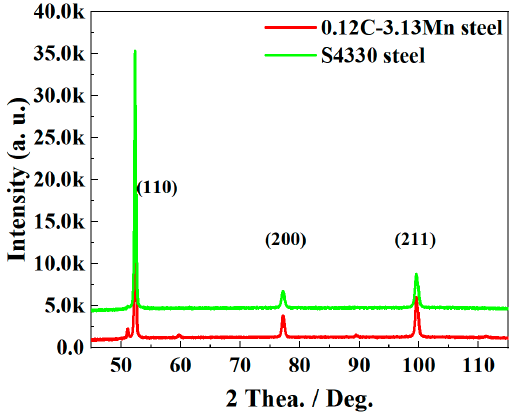
Figure 6. XRD profiles of 0.12C-3.13Mn steel and S4330 steel tempered at 600 °C for 5 h.